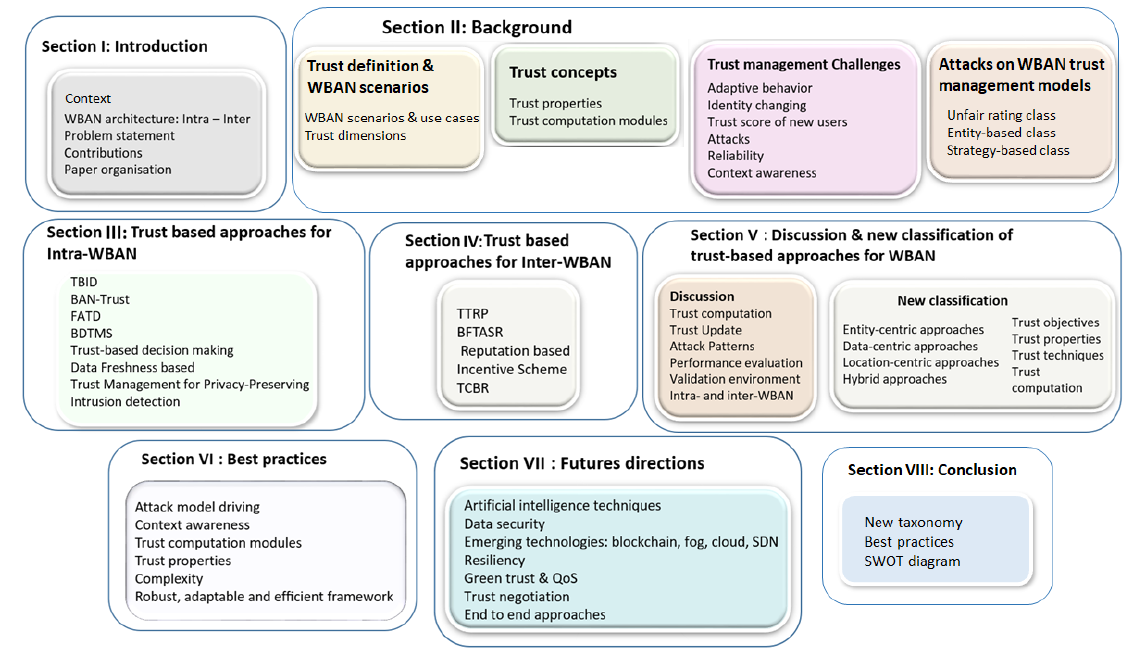
Figure 2. Survey